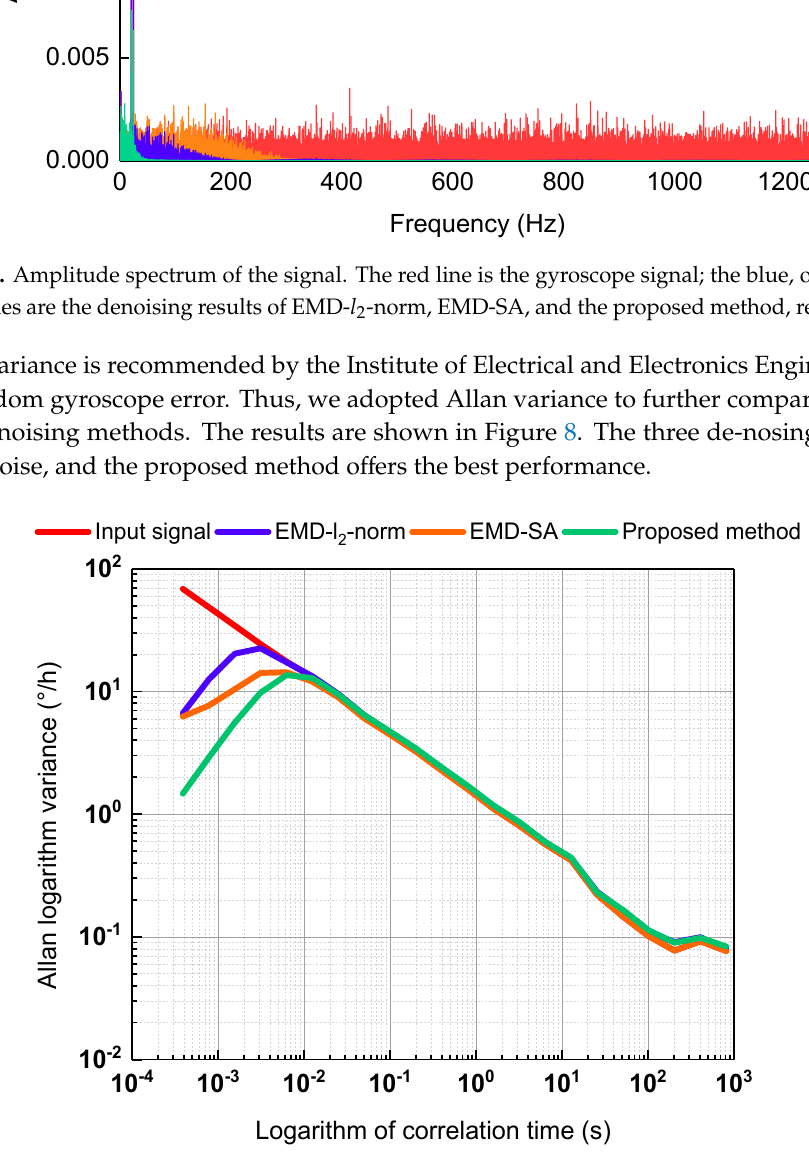
Figure 8. Allan variance analysis of the gyroscope signal and denoised signal. The red line is the gyroscope signal; the blue, orange, and green lines are the denoising results of EMD- l 2 -norm, EMD-SA, and the proposed method, respectively.